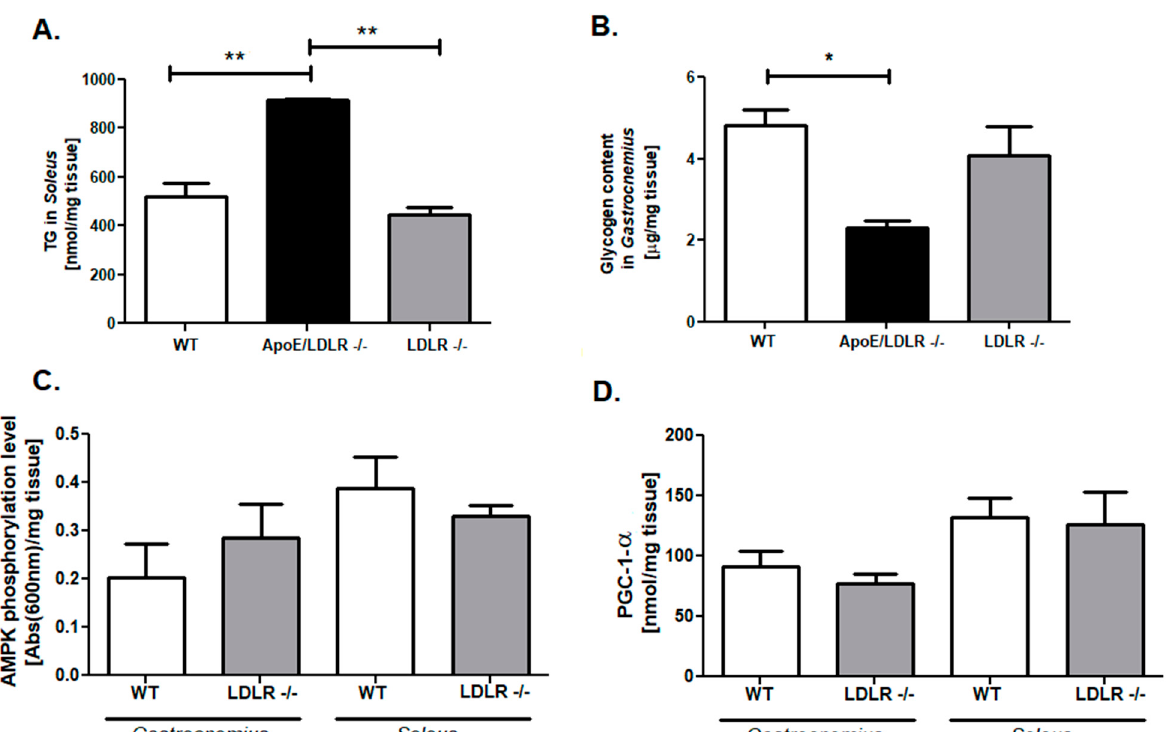
Figure 6. Elevated triglycerides stores in soleus and diminished glycogen content in gastrocnemius of ApoE/LDLR -/- but not LDLR -/- mice. Triglycerides ( A ) or glycogen ( B ) level in gastrocnemius from WT, ApoE/LDLR -/-, and LDLR -/- mice. AMP-activated protein kinase phosphorylation ( C ) and PGC-1 α levels ( D ) in gastrocnemius and soleus of WT and LDLR -/- mice. Results presented as mean ± SEM, n = 5–8, * p < 0.05, ** p <